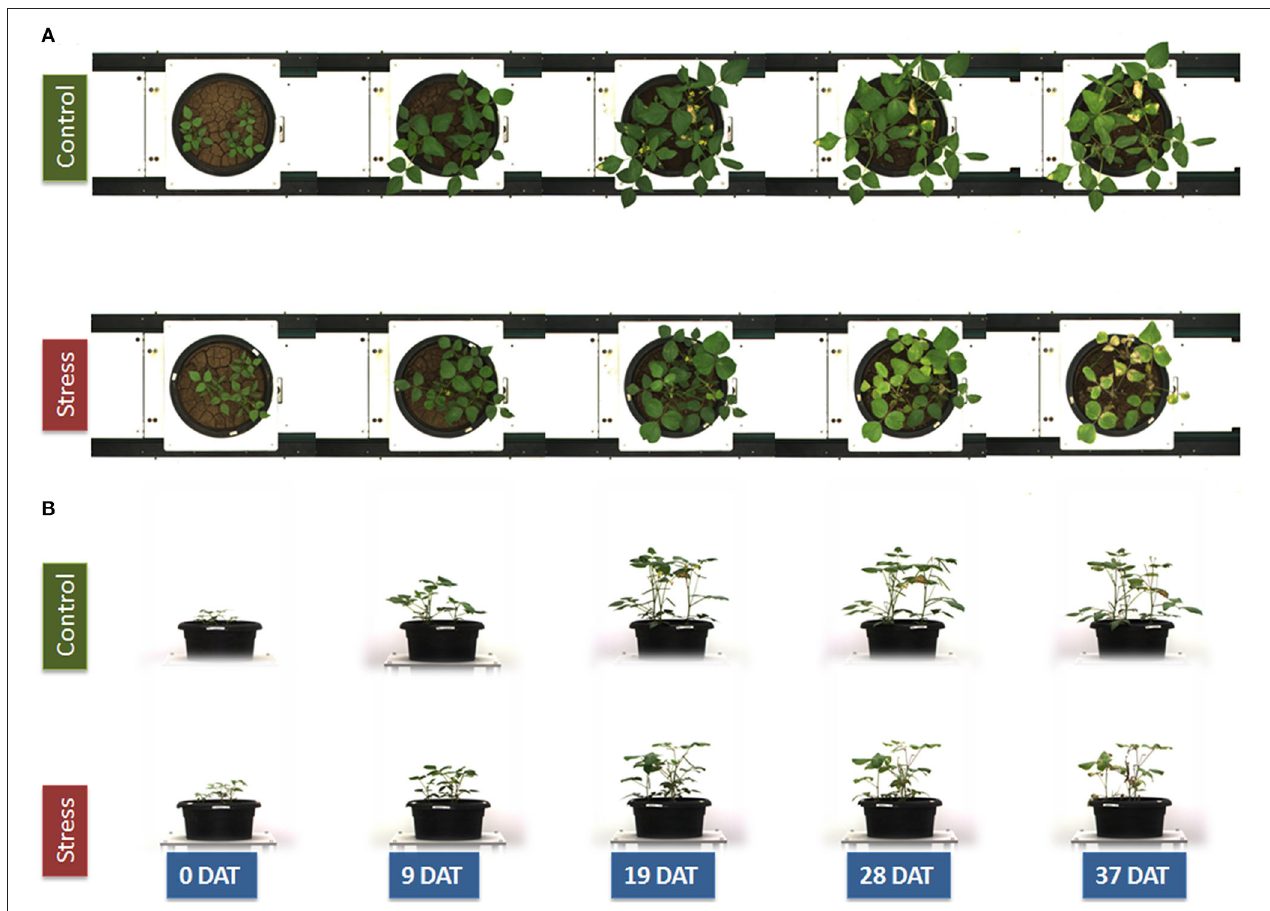
FIGURE 1 | Red green blue (RGB) image of a mungbean genotype IC-415144 on the top view (A) and side view (B) represents the same plant from 0 to 37 days of control and water stress